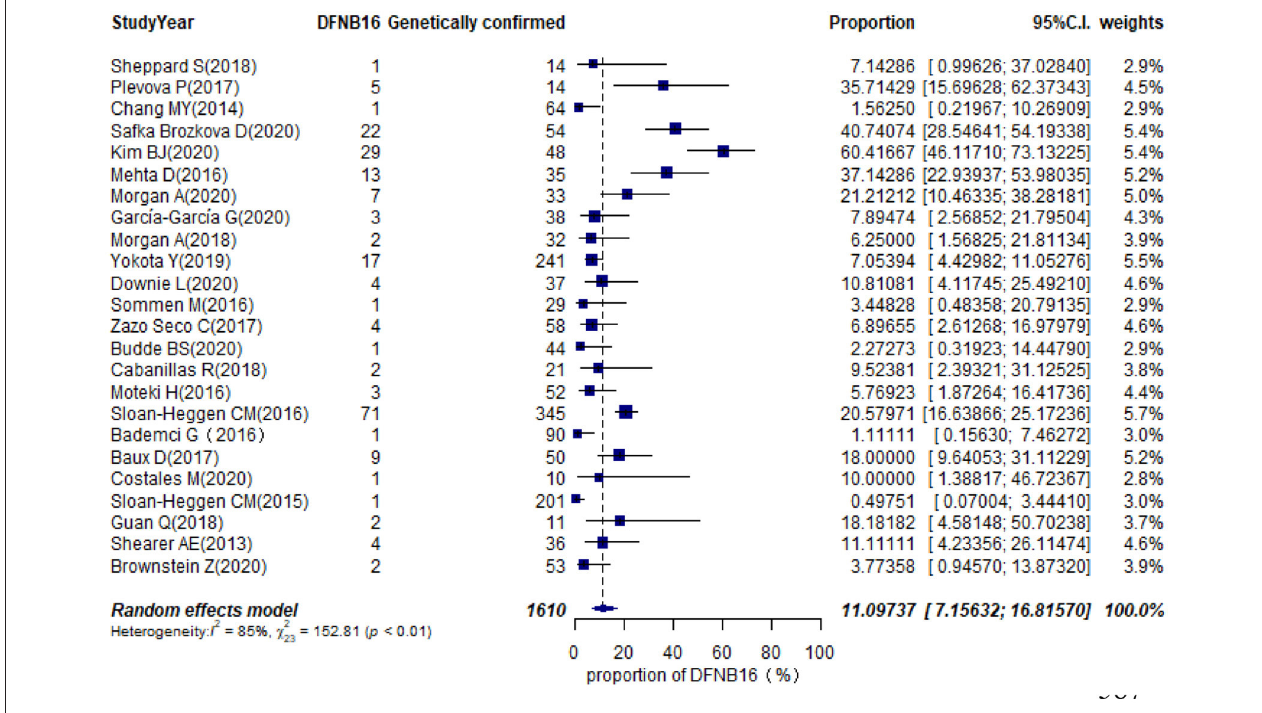
FIGURE 6 | Prevalence of DFNB16 among genetically confirmed cases (non-GJB2).